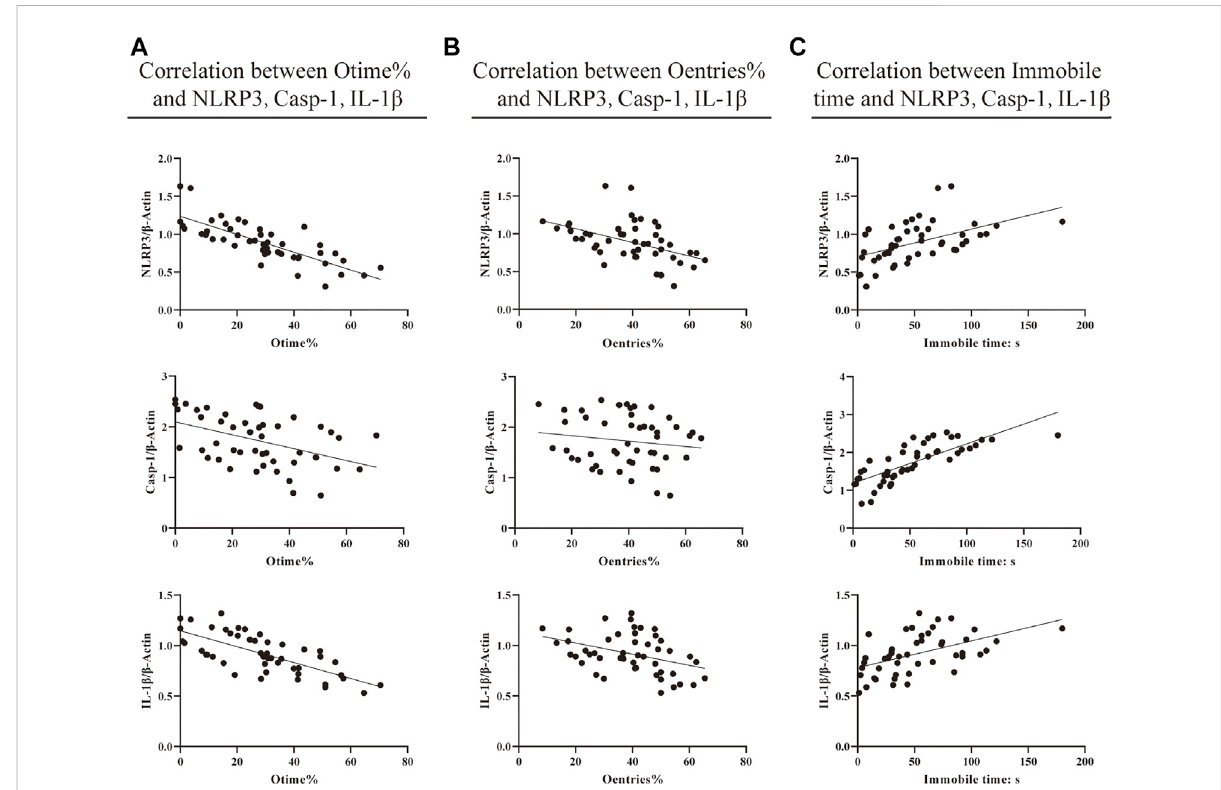
FIGURE 4 Correlation between behavioral results and neuroin fl ammation. (A) Correlation between EMP Otime% and protein expression of NLRP3, caspase-1, and IL-1 β . (B) Correlation between EMP Oentries% and protein expression of NLRP3, caspase-1, and IL-1 β . (C) Correlation between TST immobile time (s) and protein expression of NLRP3, caspase-1, and IL-1 β (Pearson correlation and linear regression analyses were performed to test potential associations of the EPM and TST with protein expression levels of NLRP3, caspase-1, and IL-1 β in the brain hippocampus of mice. Values of 0.3 ≤ |r| ≤ 0.5 were considered statistical differences, and 0.5 ≤ |r| ≤ 0.8 were considered signi fi cant